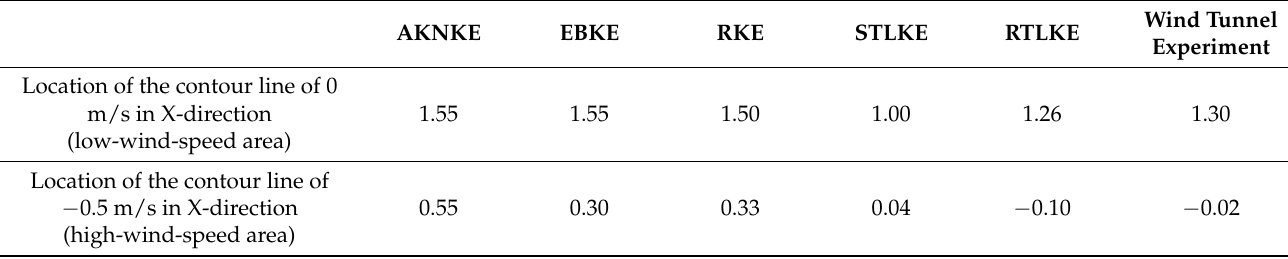
Figure 12. Contour plots of Y-velocity ( V ) at z/b = 0.125. Table 7. Location of contour line at z/b = 0.125 ( V ).